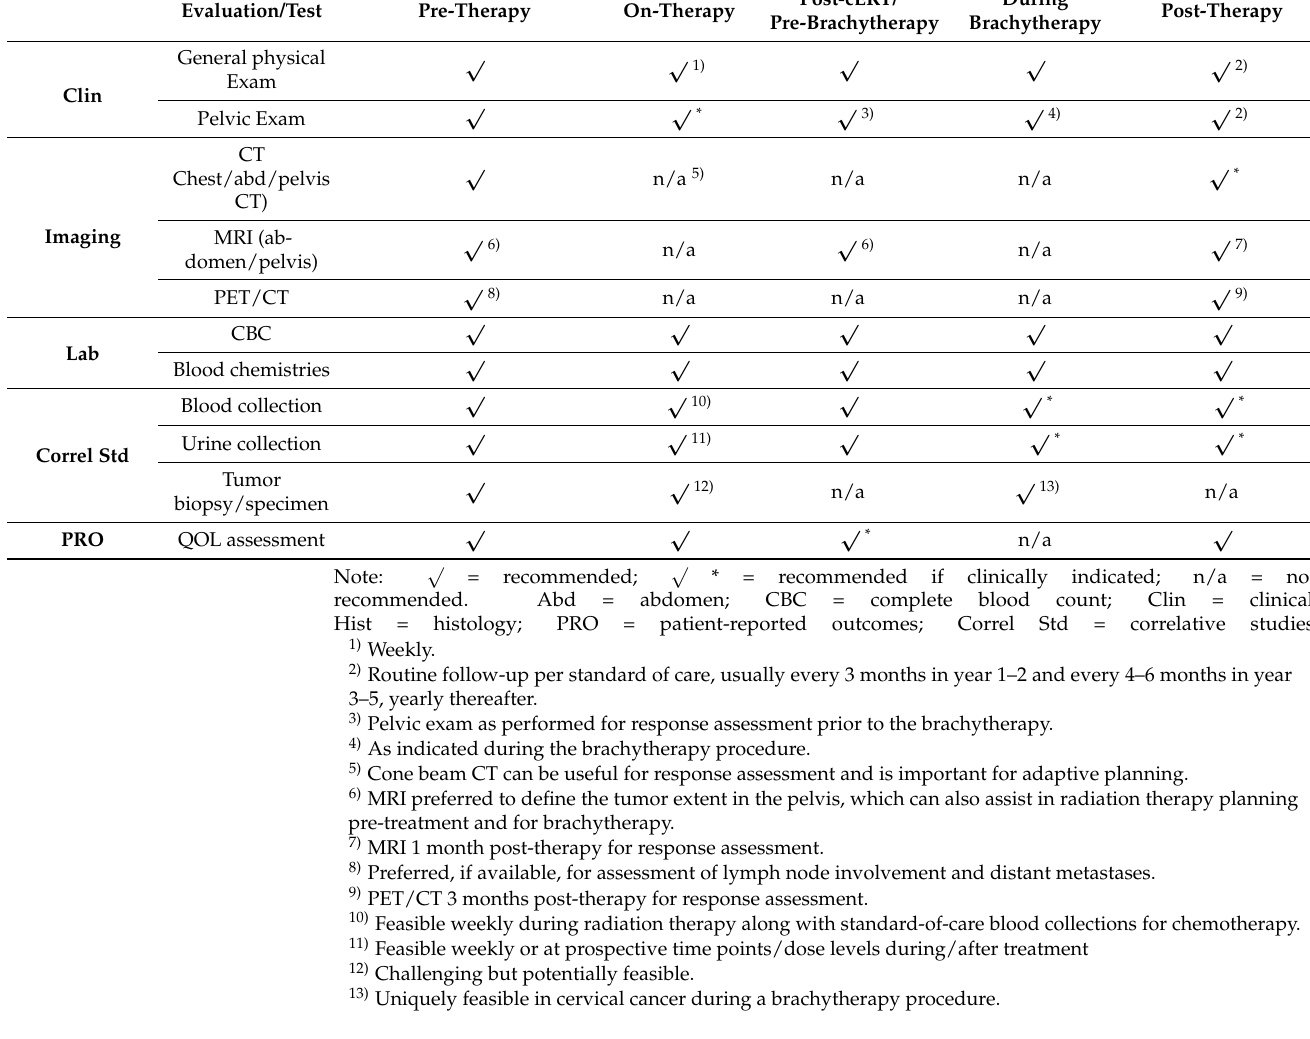
Table 4. Pre-, on-, and post-therapy patient evaluations and